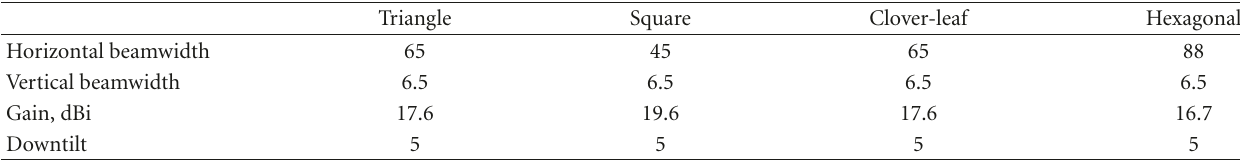
Table 1: Selected antenna parameters for di ff erent layouts. Triangle Square